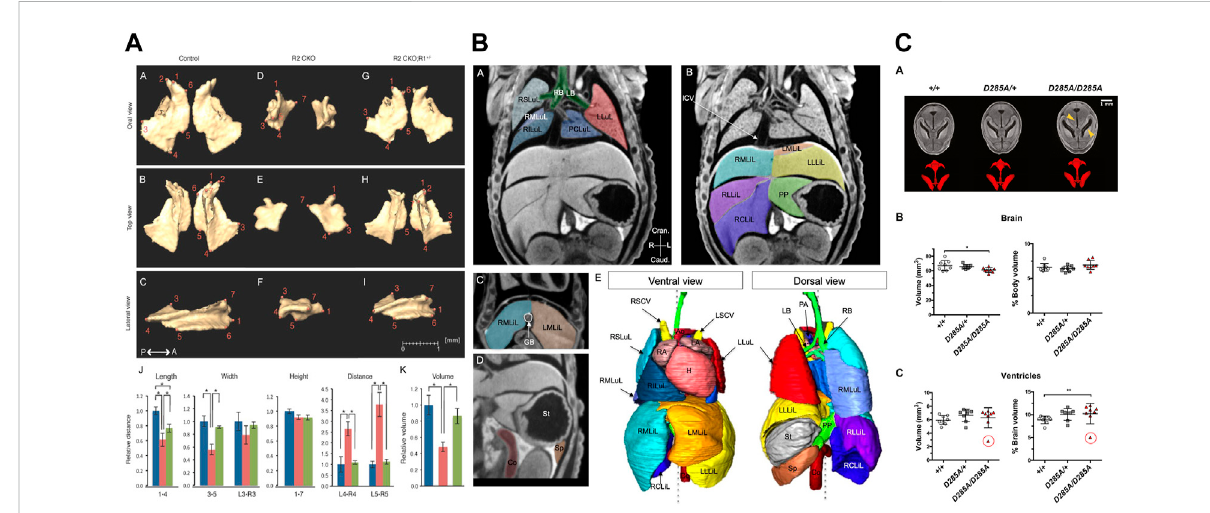
FIGURE 6 MicroCT for quantitative analysis of mutant mouse embryos. (A) Linear distance measurements and volume measurements quantify malformations in skull bones after loss of transforming growth factor beta (TGF β ) [Figure 5 from Ho et al., 2015, Developmental Biology 400 (2)]. (B) Imagesegmentationusedforvolumetryanalysisofabdominalorgans[Figure3fromDesgrangeetal.,2019,DiseaseModels&Mechanisms12(7)]. (C) Volumetry analysis of perinatally lethal homozygous Oga D285A/D285A mice showing defects in the brain and its ventricles (Figure 6 from Muha et al., 2021, Journal of Biological Chemistry 296). All images reprinted under the terms of the Creative Commons Attribution